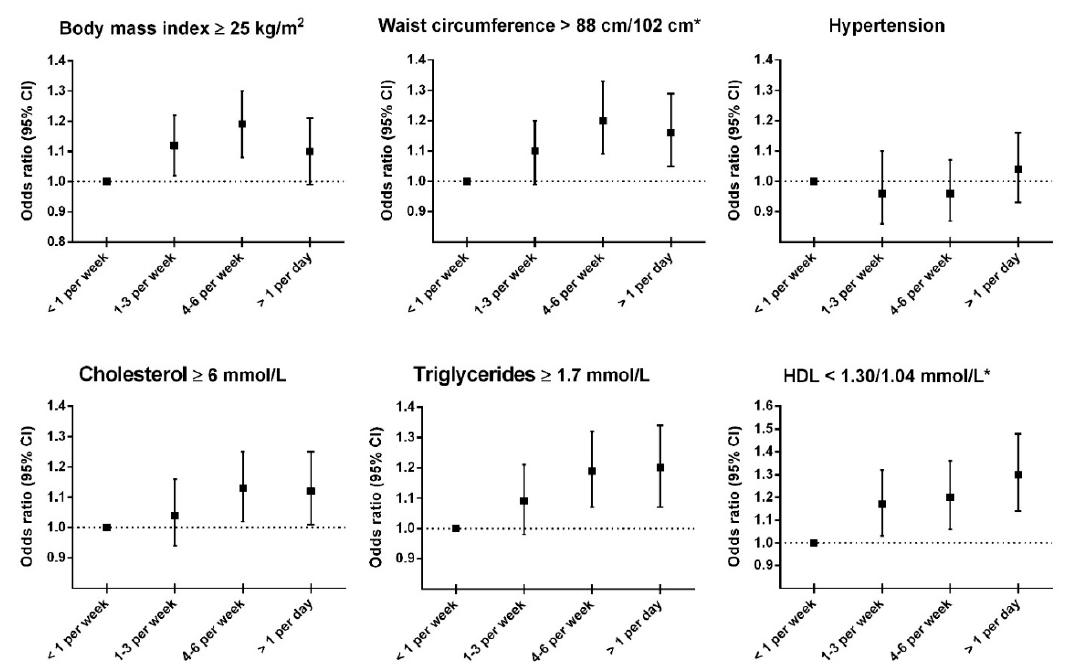
Figure 1. Odds ratios for adverse levels of adiposity, hypertension and blood lipids according to potato consumption. HDL = high-density lipoprotein cholesterol. * Cut-off values are sex-specific for waist circumference and HDL; Waist circumference, > 88 cm for women and > 102 cm for men; HDL, < 1.30 mmol / L for women and < 1.04 mmol / L for men. Abbreviations: HDL = high-density lipoprotein. Adjusted for age (continuous), sex (woman, man), cardiovascular disease (no, yes), work type (mostly sedentary, much walking, much lifting, heavy work, unknown / not employed), frequency of physical activity (none, < 1, 1, 2–3, ≥ 4 times per week), smoking (never, former, current), intake of alcohol ( ≤ 1 month, ≤ 1 per week, ≥ 2 per week, abstainer), intake of vegetables ( ≤ 3 times per week, 4–6 times per week, ≥ 1 times per day), intake of fish ( ≤ 3 times per month, 1–3 times per week, ≥ 4 times per week), intake of processed meat ( ≤ 3 times per month, 1–3 times per week, ≥ 4 times per week), intake of pasta / rice ( ≤ 3 times per month, 1–3 times per week, ≥ 4 times per week). All outcomes except body mass index and waist circumference were adjusted also for body mass index.